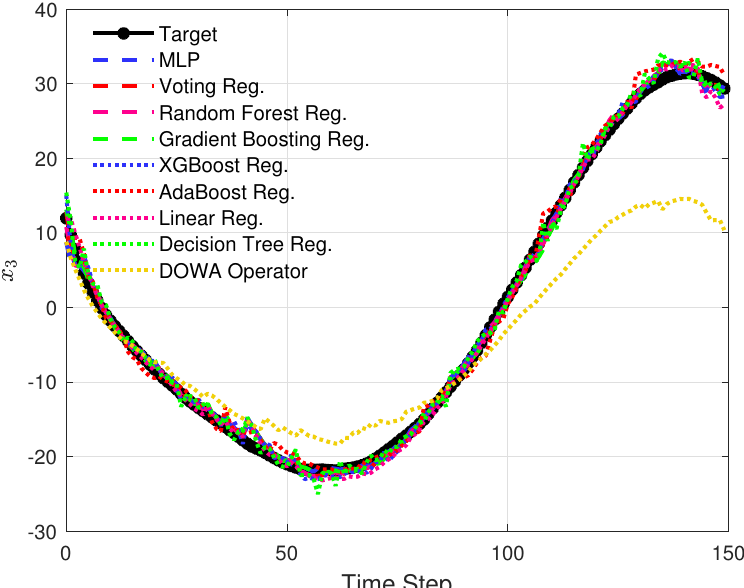
Figure 14. Fusion results for one Monte Carlo simulation for state 3.